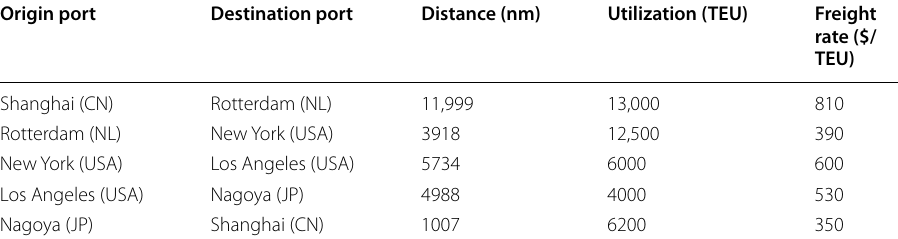
Table 9 Case study inputs. Source based on Searoutes